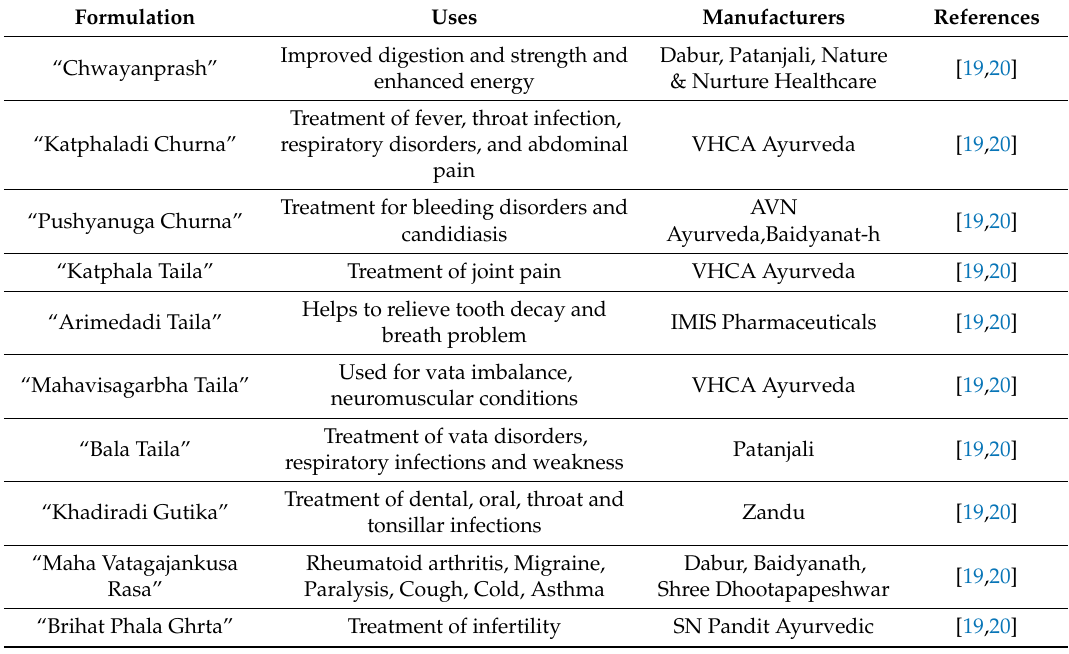
Table 1. Ayurvedic formulations of the plant with their uses and manufacturers.